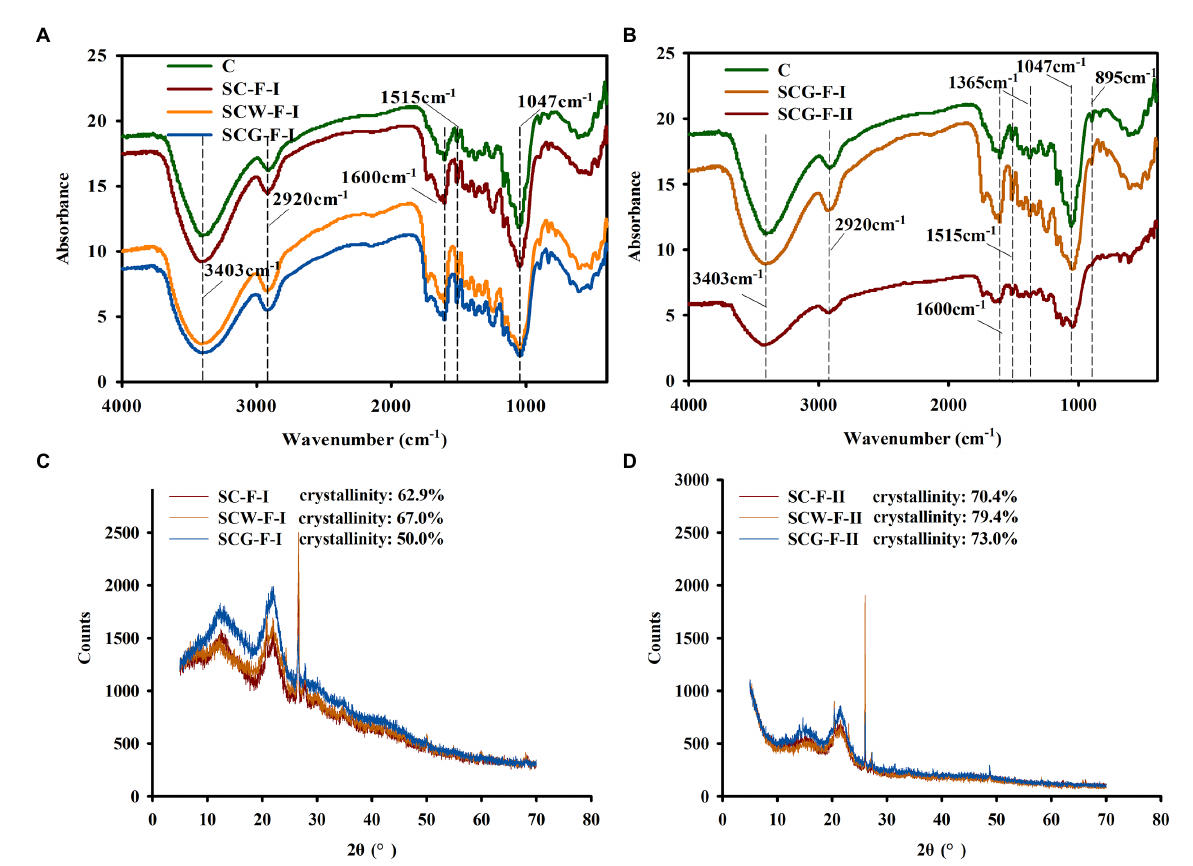
FIGURE 5 Fourier transform-infrared spectroscopy (FT-IR) and X-ray diffraction analysis of different corn straw samples. (A) Infrared spectrum analysis of cornstalk samples after treatment with straw-degradation agent and microbial consortium G123 for 11 weeks; (B) Variations in functional groups of corn straw samples after treatment with microbial consortium G123 for 11 and 17 weeks. (C) X-ray diffraction pattern of cornstalk samples after treating with 11 weeks; (D) X-ray diffraction pattern of cornstalk samples after treating with 17